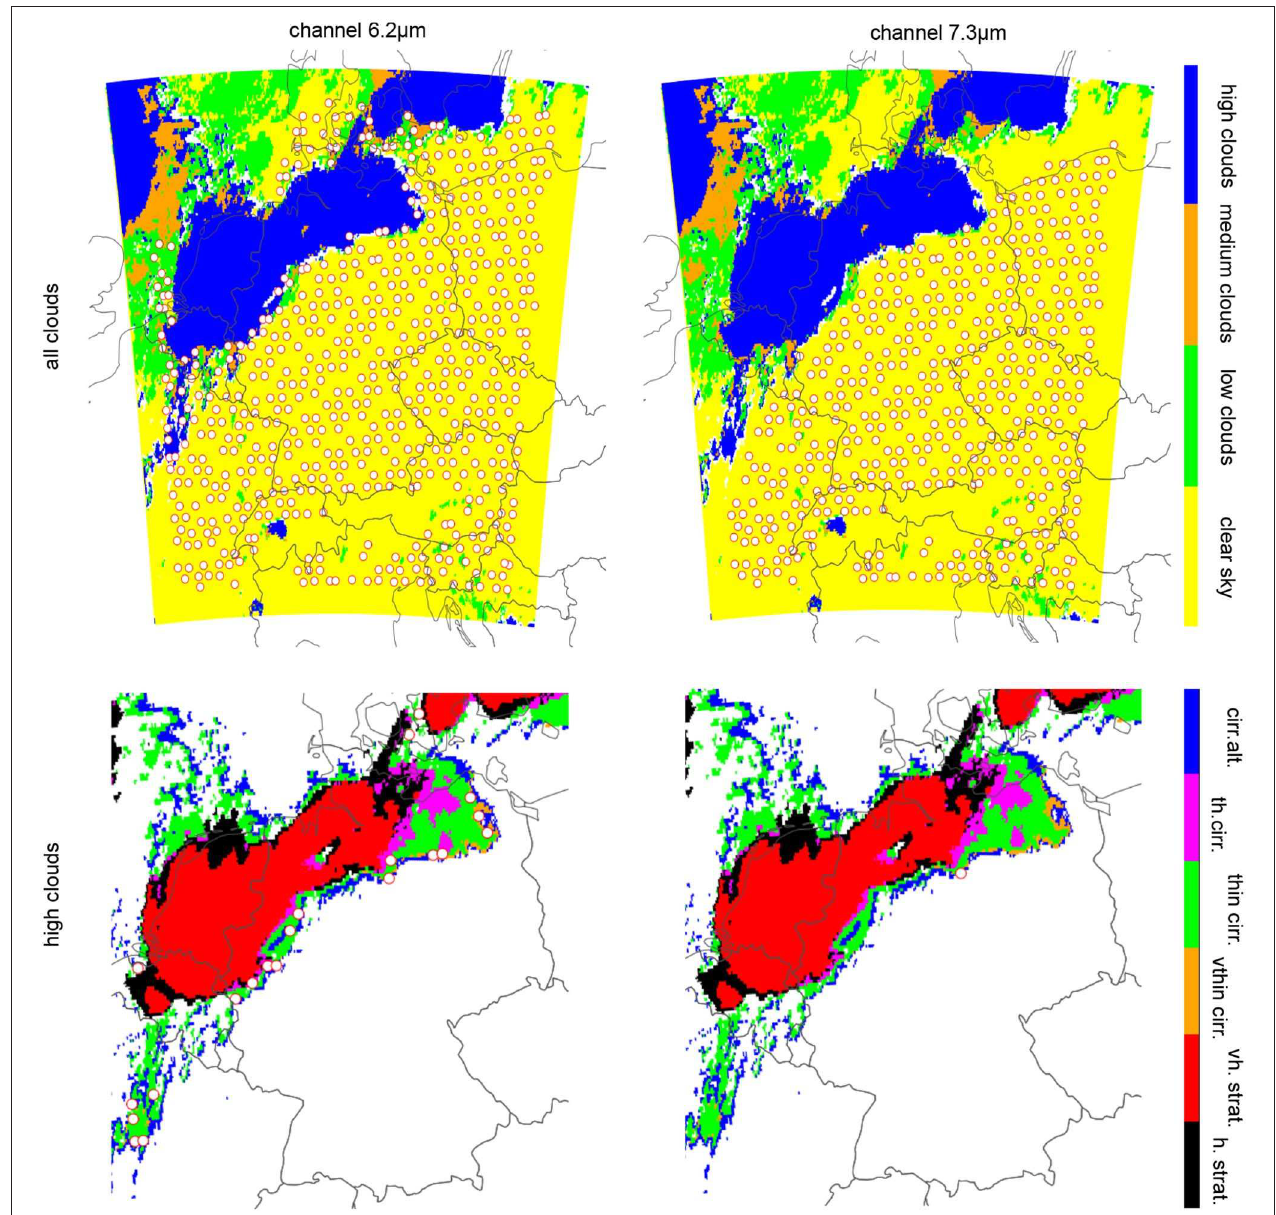
FIGURE 6 | Example ZCI-cloud distribution over COSMO-DE domain at June 23, 20 UTC. The color decodes the cloud types (see color bars at right hand side) for all cloud types (top panel) and high clouds (bottom panel) for SEVIRI channels 6.2 µ m (left) and 7.3 µ m (right). The circles denote locations of ZCI-observations. The high cloud distribution (bottom panel) is plotted on a smaller region for illustration